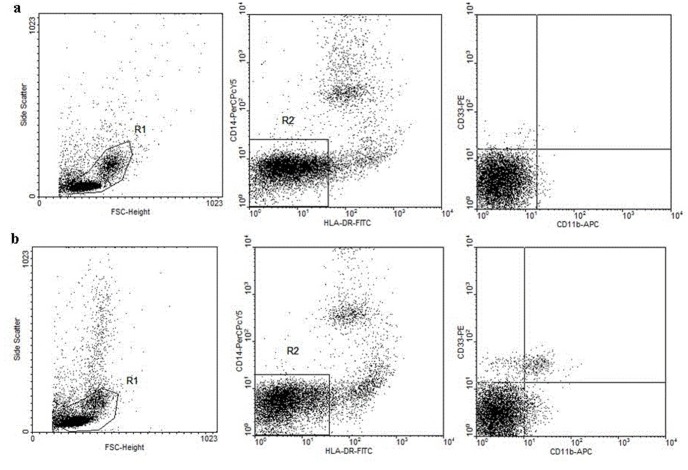
The frequency of circulating MDSCs (HLA-DR−/CD14−/CD11b+/CD33+ cells) increased in ECA patients.The frequency of MDSCs in PBMC was analyzed by flow cytometry, the patients and healthy controls used in this experiment had been matched with sex, age and number. a: Representative diagram of flow cytometry analysis for circulating MDSCs from healthy controls. b: Representative diagram of flow cytometry analysis for circulating MDSCs from ECA patients. MDSCs, myeloid-derived suppressor cells; ECA, esophageal cancer; FSC, forward scatter; FITC, fluorescein isothiocyanate; PerCP-Cy5.5, peridinin chlorophyll protein-cyanin 5.5; PE, phycoerythrin; APC, allophycocyanin.